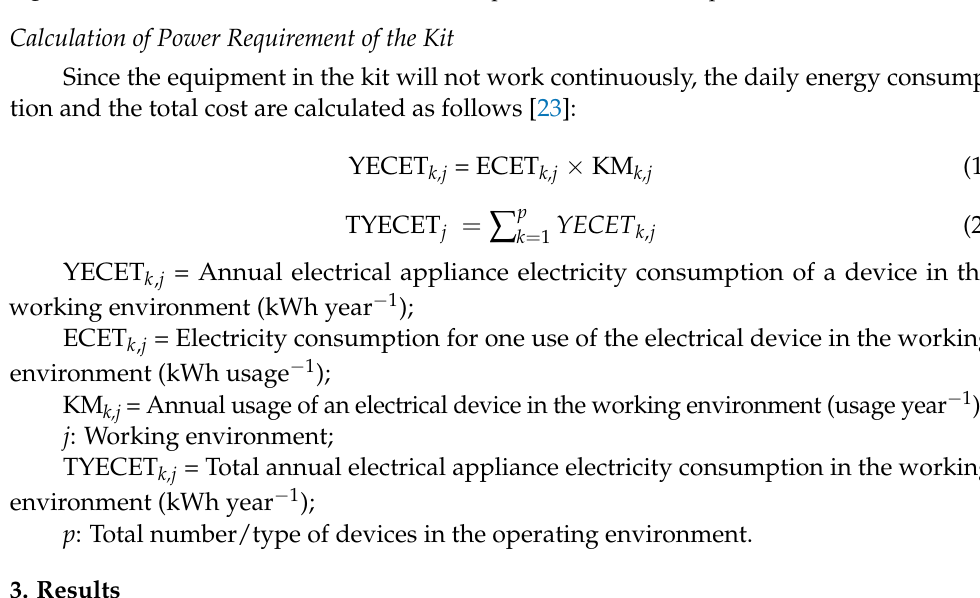
Figure 4. Demonstration of the connection and operation of the developed automation